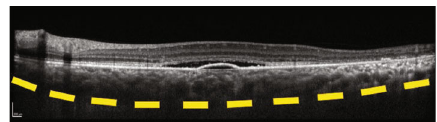
Figure 5: Optical coherence tomography in central serous chorioretinopathy. Note the pigment epithelial detachment and subretinal fl uid. Enhanced depth imaging shows a thickened choroid (yellow dashes indicate the sclerochoroidal